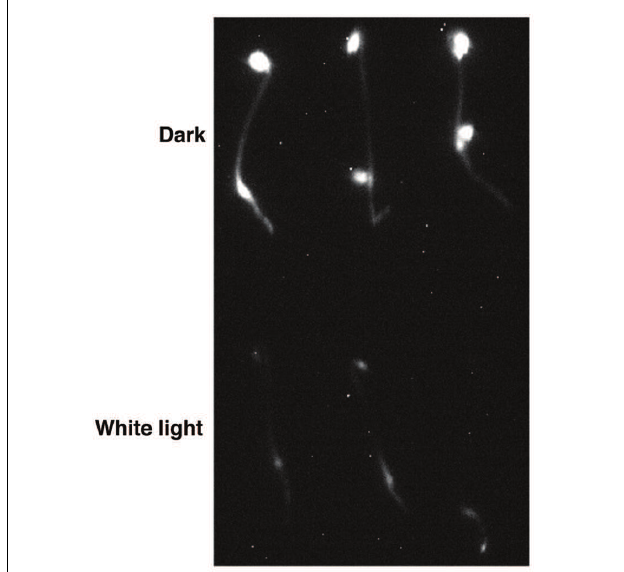
FIGURE 1 | LUC-PIF1 seedlings showed reduced luminescent signal upon white light exposure compared with dark grown seedlings. Three-day-old dark grown LUC-PIF1 transgenic seedlings were either kept in the dark or exposed to white light for 15 min. One millimeter Luciferin solution was sprayed on the seedlings. The plates remained in the dark for another 5 min before being imaged by the NightOWL